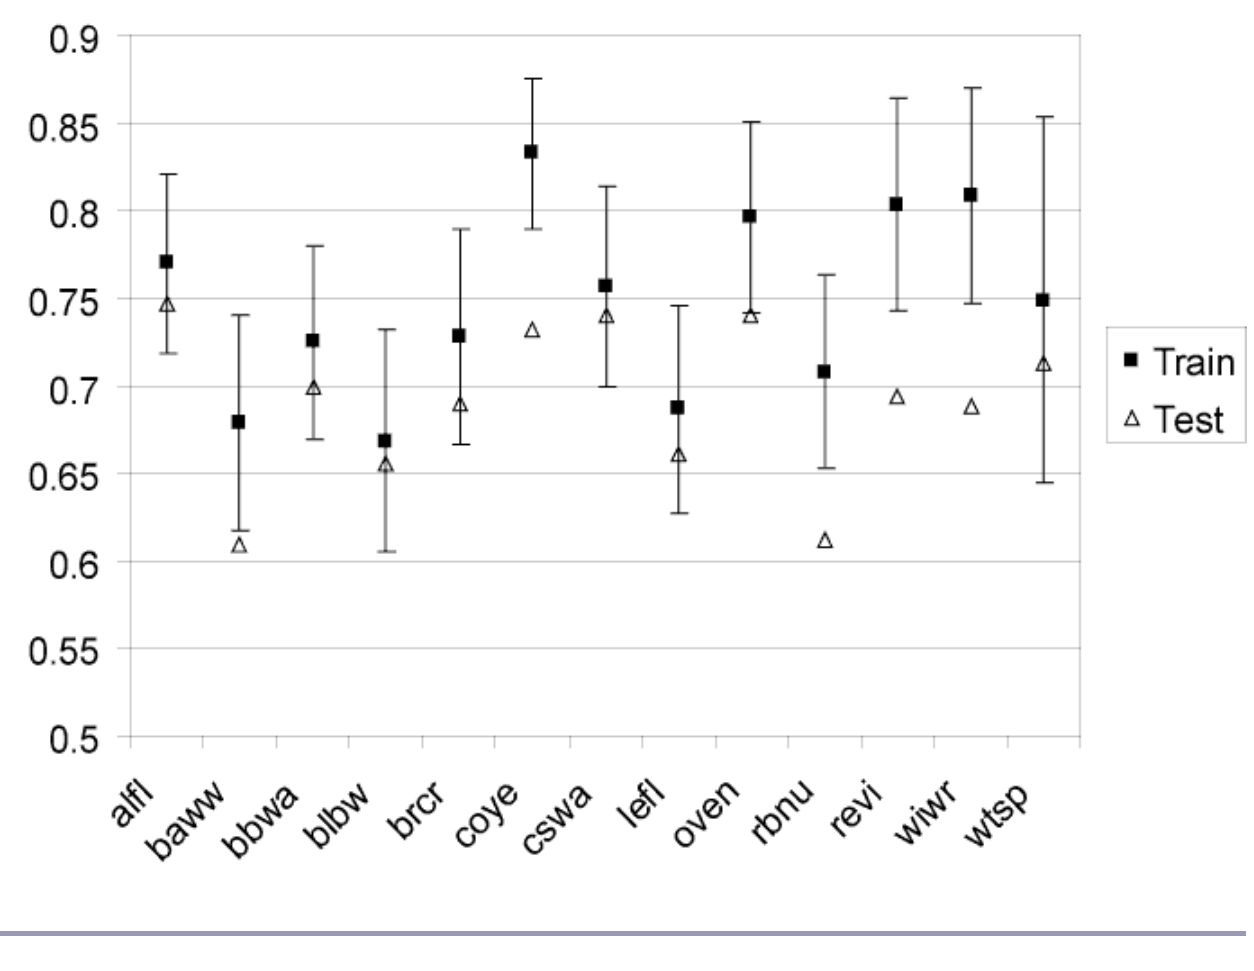
Fig. 4. Accuracy assessment (ROC) and 95% confidence limits for the focal species habitat models. Values are area under the ROC curve, and represent the probability of correctly assigning the correct label (occupied/unoccupied) for new observations. Closed symbols are for model development (training), and open symbols for independent testing of the